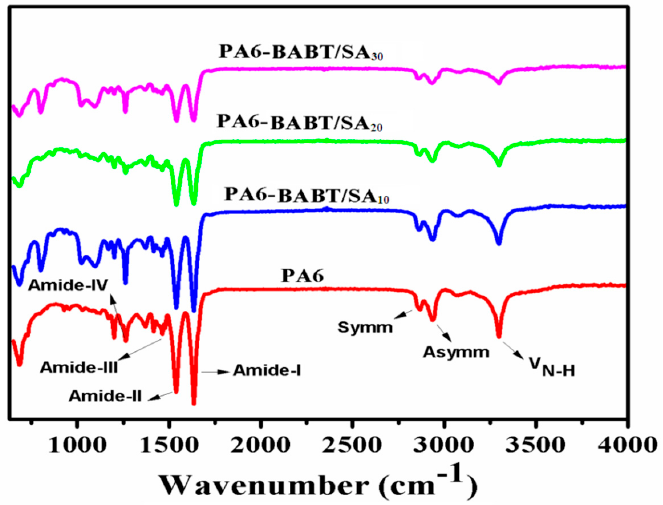
Figure 5. FT-IR spectra of PA 6 and PA6-BABT/SA copolyamides.